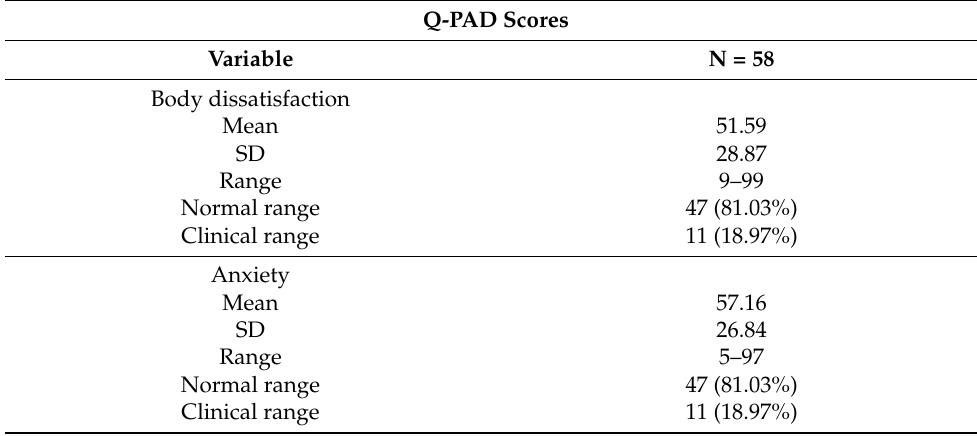
Figure 1. Distribution of adolescents with epilepsy on the Q-PAD. Figure legend: distribution of Q-PAD scores (minimum score, first (left) quartile, median, third (right) quartile, and maximum score), ° outlier value. Abbreviations: Q-PAD: Questionnaire for the Assessment of Psychopathology in Adolescence. Table 2. Q-PAD scores.